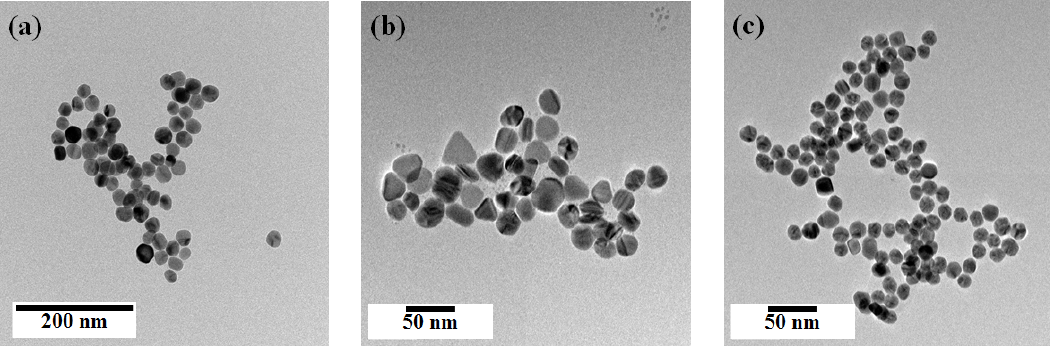
Figure 2. TEM images of ( a ) spherical Ag NPs, ( b ) multi-shaped Ag NPs, and ( c ) Au NPs.